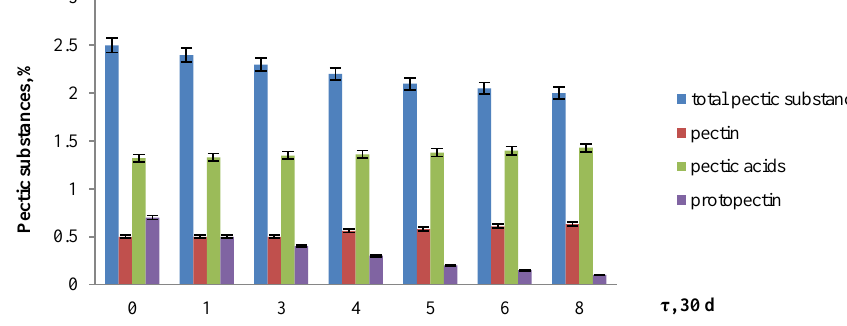
Fig. 4. Pectic substances content of dates during storage at +4